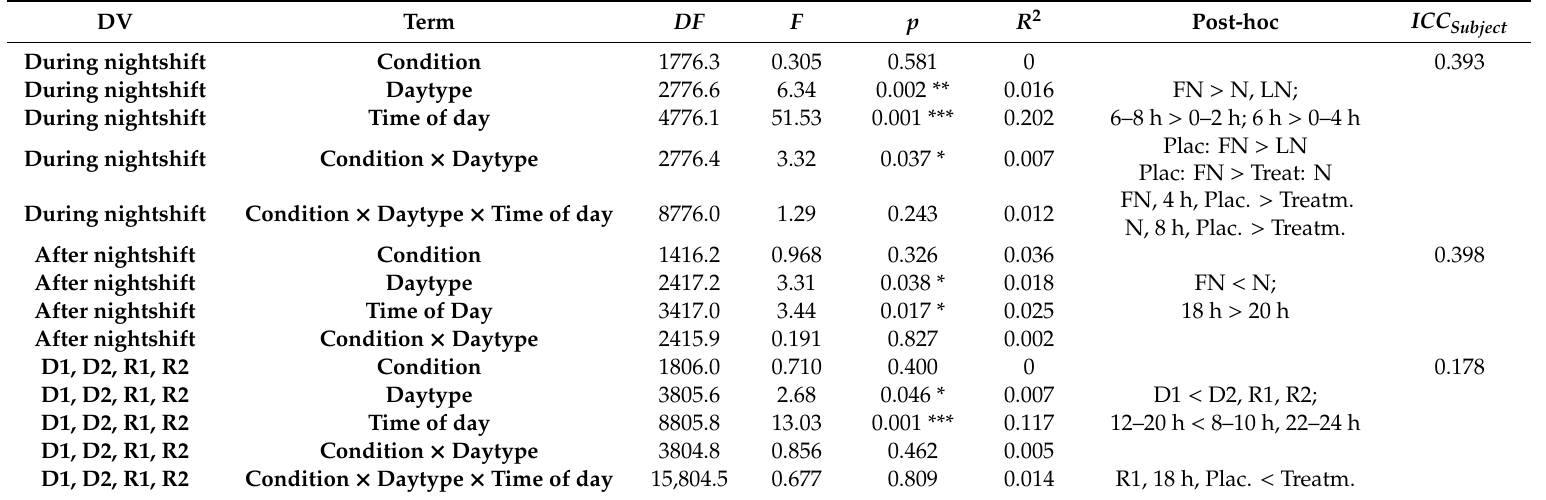
Table A3. Results of the LMM analyses of sleepiness (KSS).